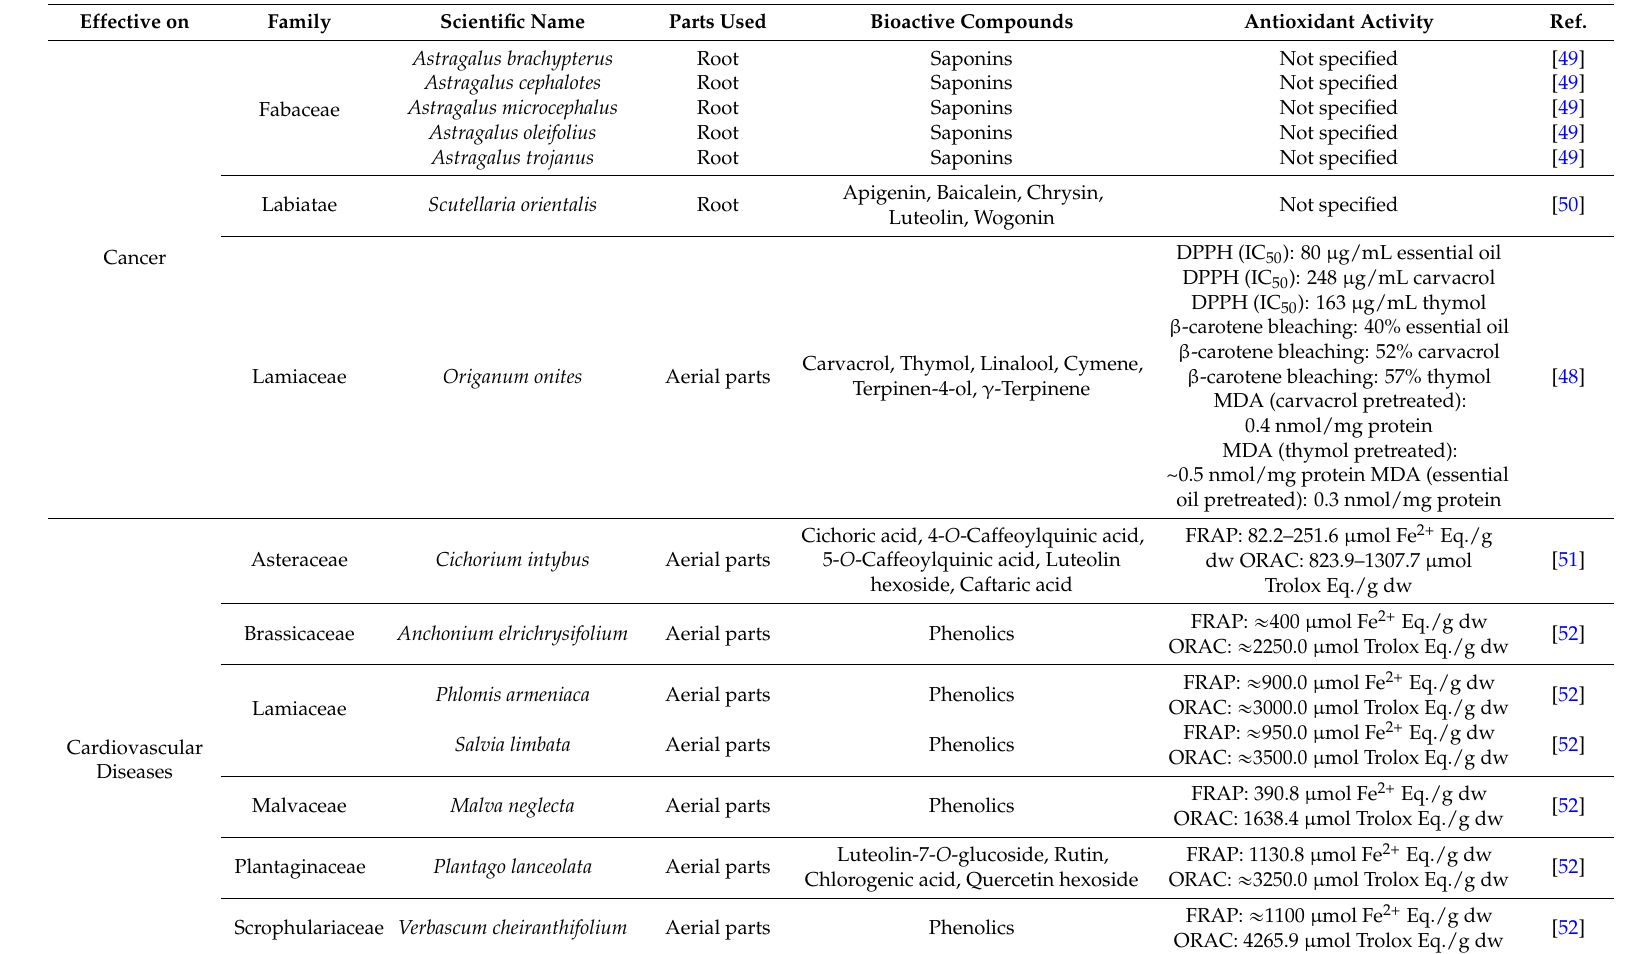
Table 1. Documented therapeutic effects of medicinal plants in